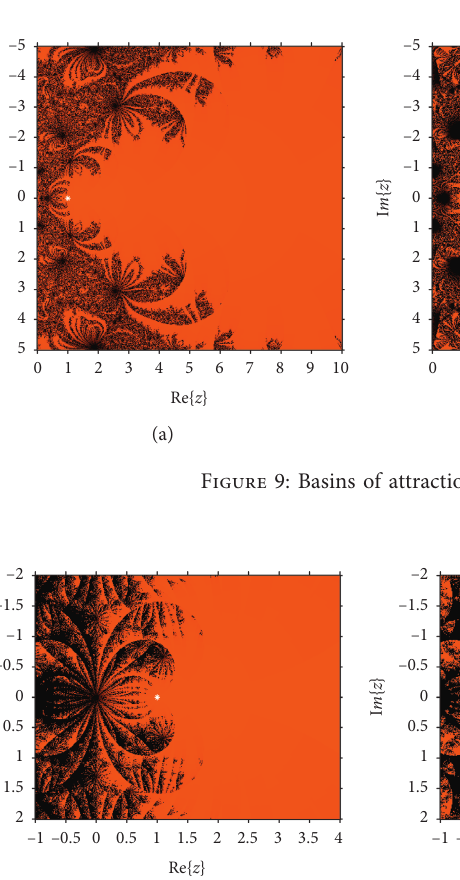
Figure 10: Basins of attraction of (a) SFM1, (b) SFM2, and (c) SFM3 for g